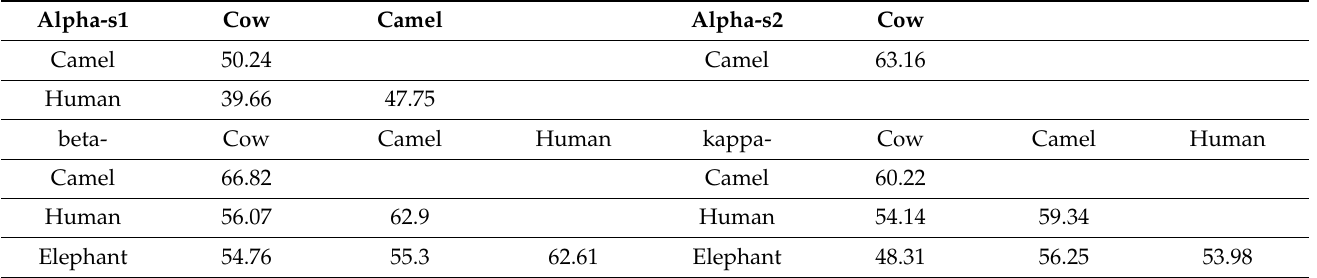
Table 2. Sequence identity between the α s1-, α s2-, β - and κ -caseins of the studied milks including the signal peptides (%)